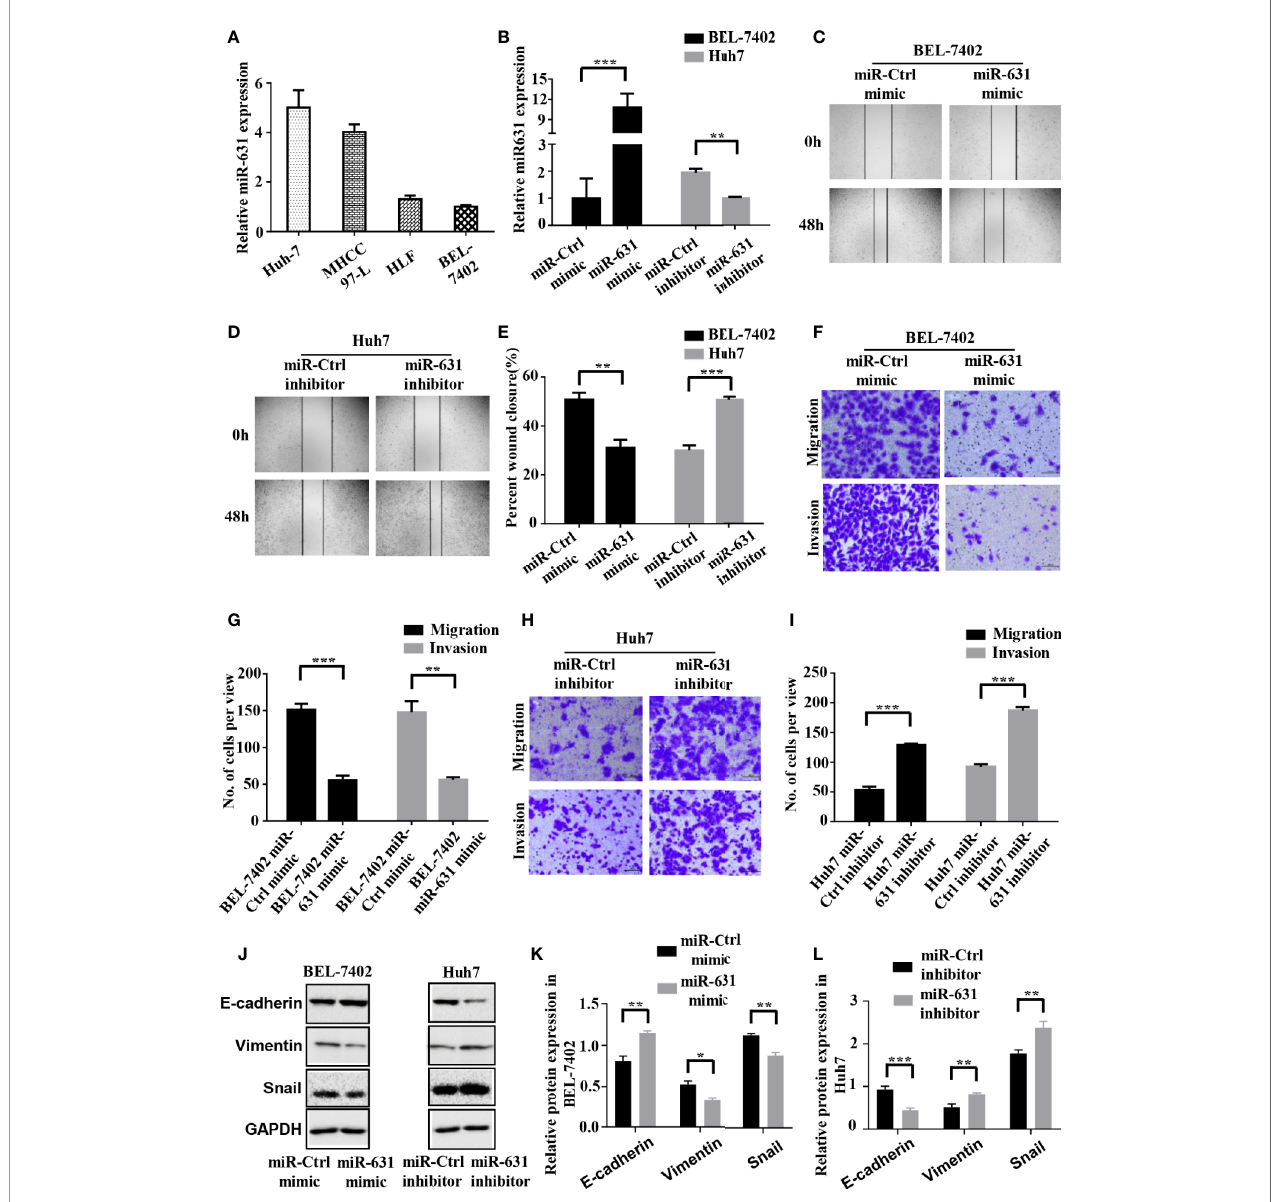
FIGURE 2 | miR-631 inhibits migration and invasion of HCC cells. (A) Expression of miR-631 in in vivo HCC cell lines. (B) Relative expression of miR-631 detected by qRT-PCR in BEL-7402 cells transfected by miR-Control or miR-631 mimic and Huh7 cells transfected by miR-Control or miR-631 inhibitor. The concentration of mimic and inhibitor is 50 nM. (C – E) Representative images of wound healing assays and percentages of wound closure were calculated. (F, G) Transwell migration and invasion assays of BEL-7402. (H, I) Transwell migration and invasion assays of Huh7. (J – L) Western blot assay of protein in EMT. Results were represented as mean ± S.E.M. (n = 3) *P < 0.05; **P < 0.01; ***P <